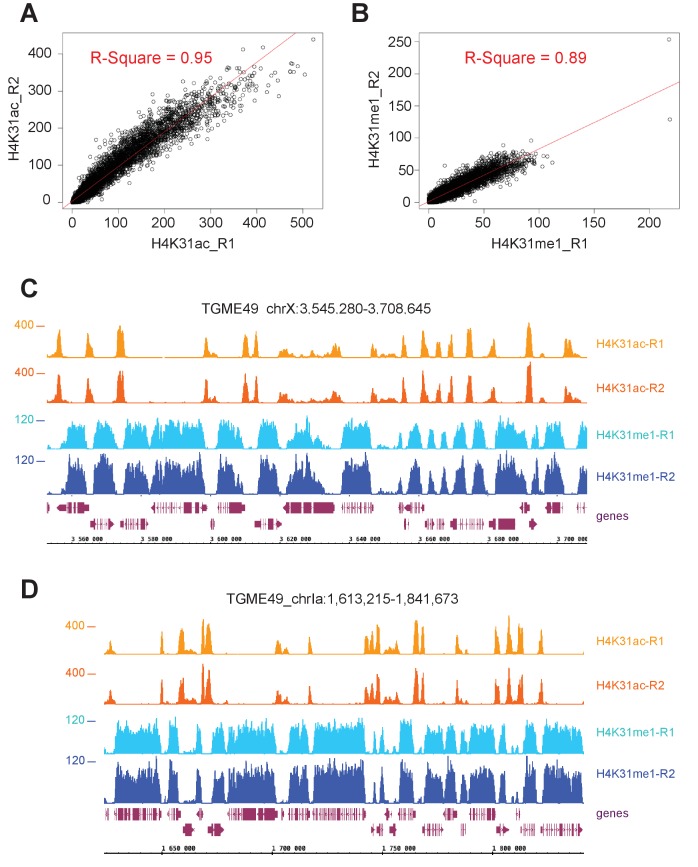
ChIP-seq enrichments in biological replicates are highly correlated.Scatterplot comparing the difference in H4K31ac (a) or H4K31me1 (b) enrichment measured in the two independent replicate experiments. The x- and y-axes show the average tag count of the enrichment. IGB screenshot of T. gondii Chr. X (c) and Ia (d) genomic regions showing reads for H4K31ac (replicates R1 and R2) and H4K31me1 (replicates R1 and R2).